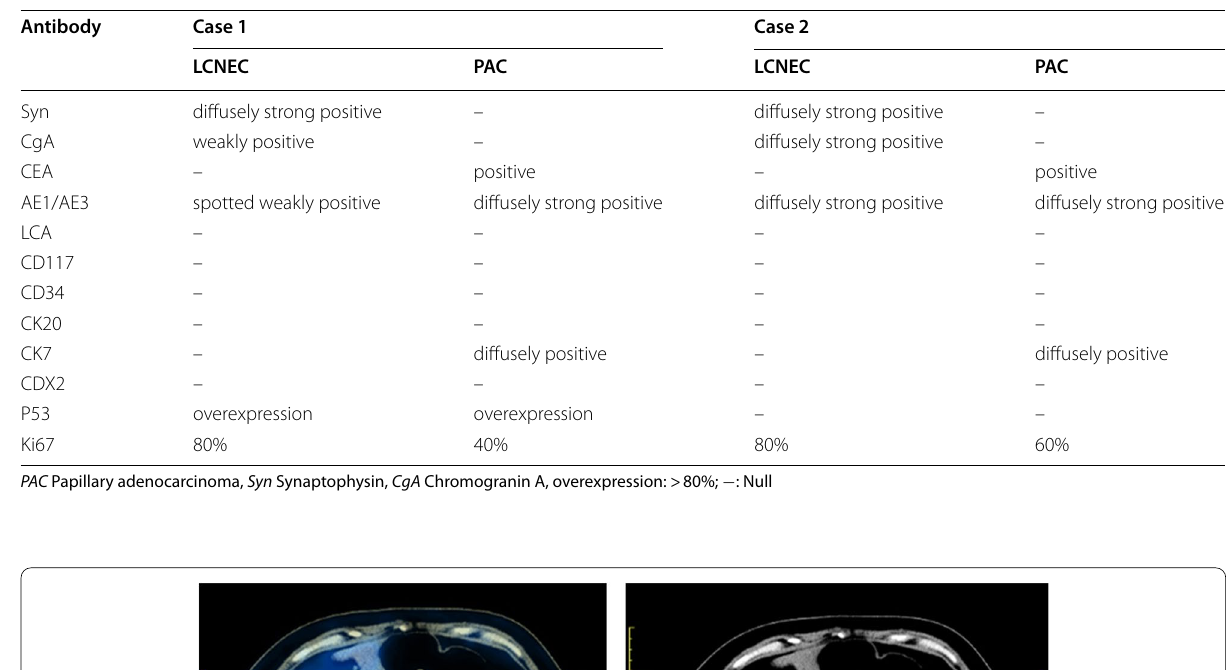
Table 1 Immunohistochemical staining findings in two cases of gallbladder MiNENs